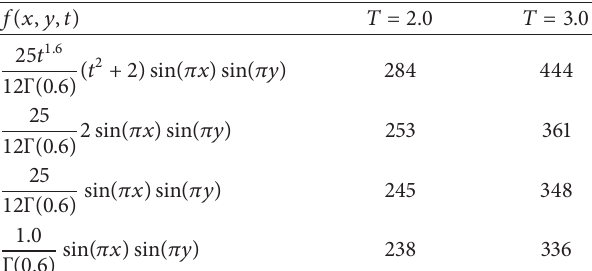
Table 2: Impact of the source term on iteration times.